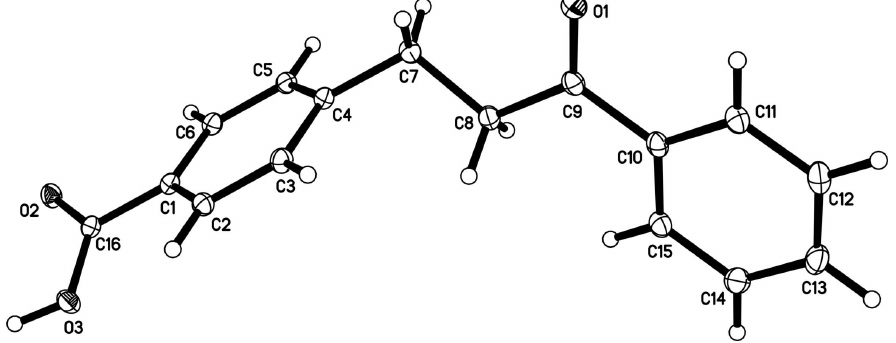
The asymmetric unit of (I), with its numbering. Displacement ellipsoids are drawn at the 30% probability level.